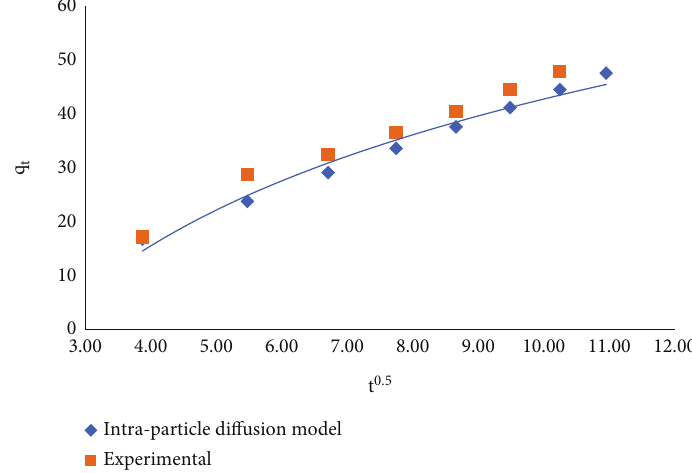
Figure 9: Kinetic studies of PA adsorption onto ACO ( dosage = 50 mg , C 25 ± 1 ° C ).